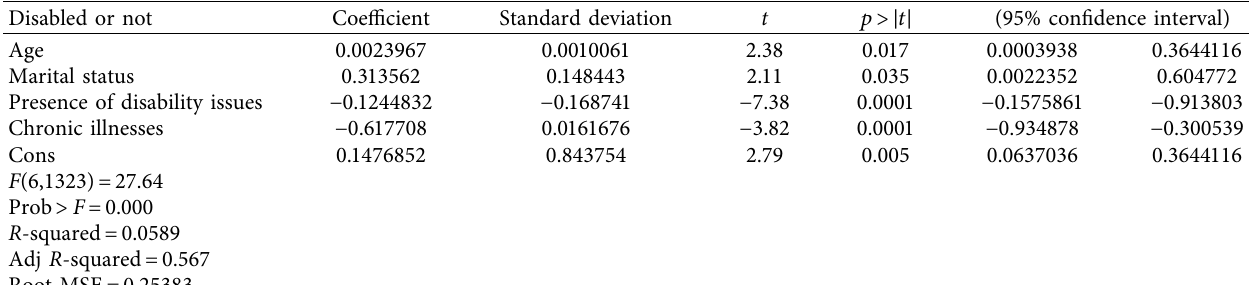
Table 4: Results of the stepwise multiple